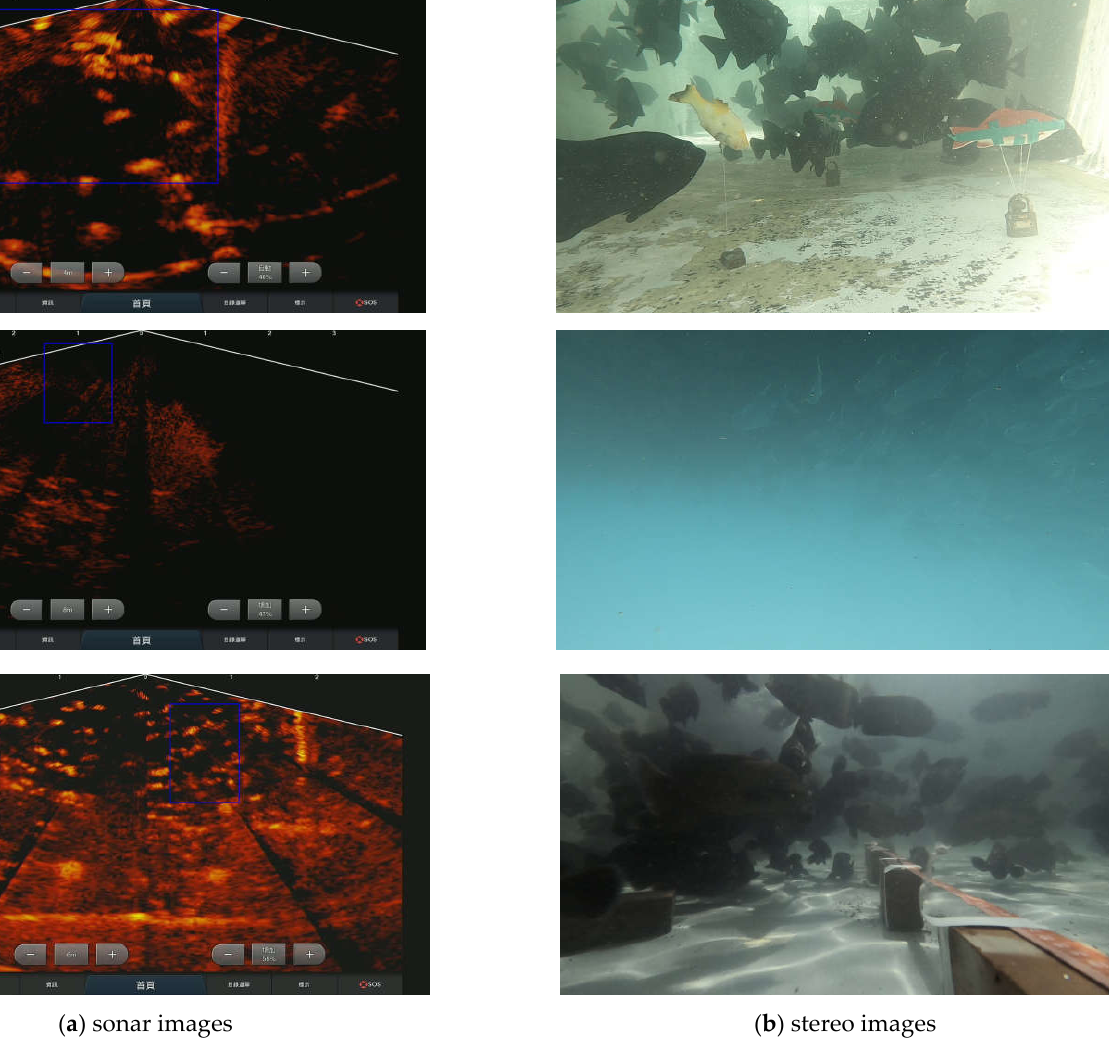
Figure 20. Bounding box detection results from the sensor fusion.